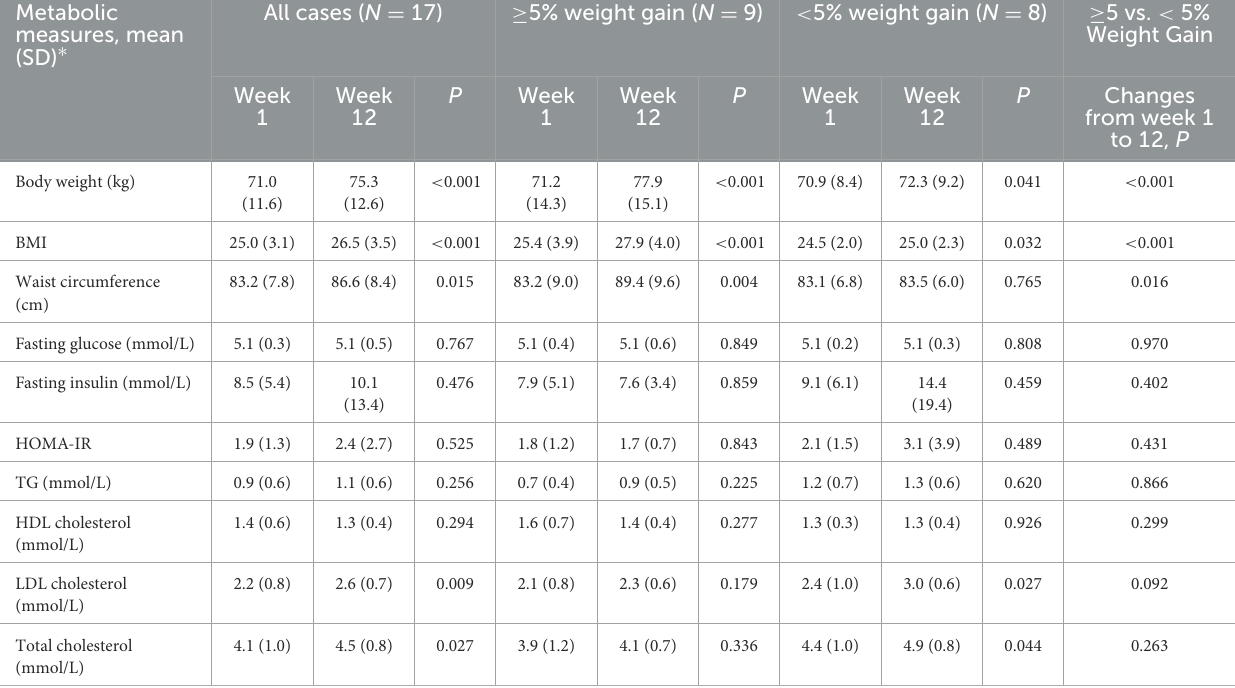
TABLE 2 Changes in metabolic measures between baseline and week